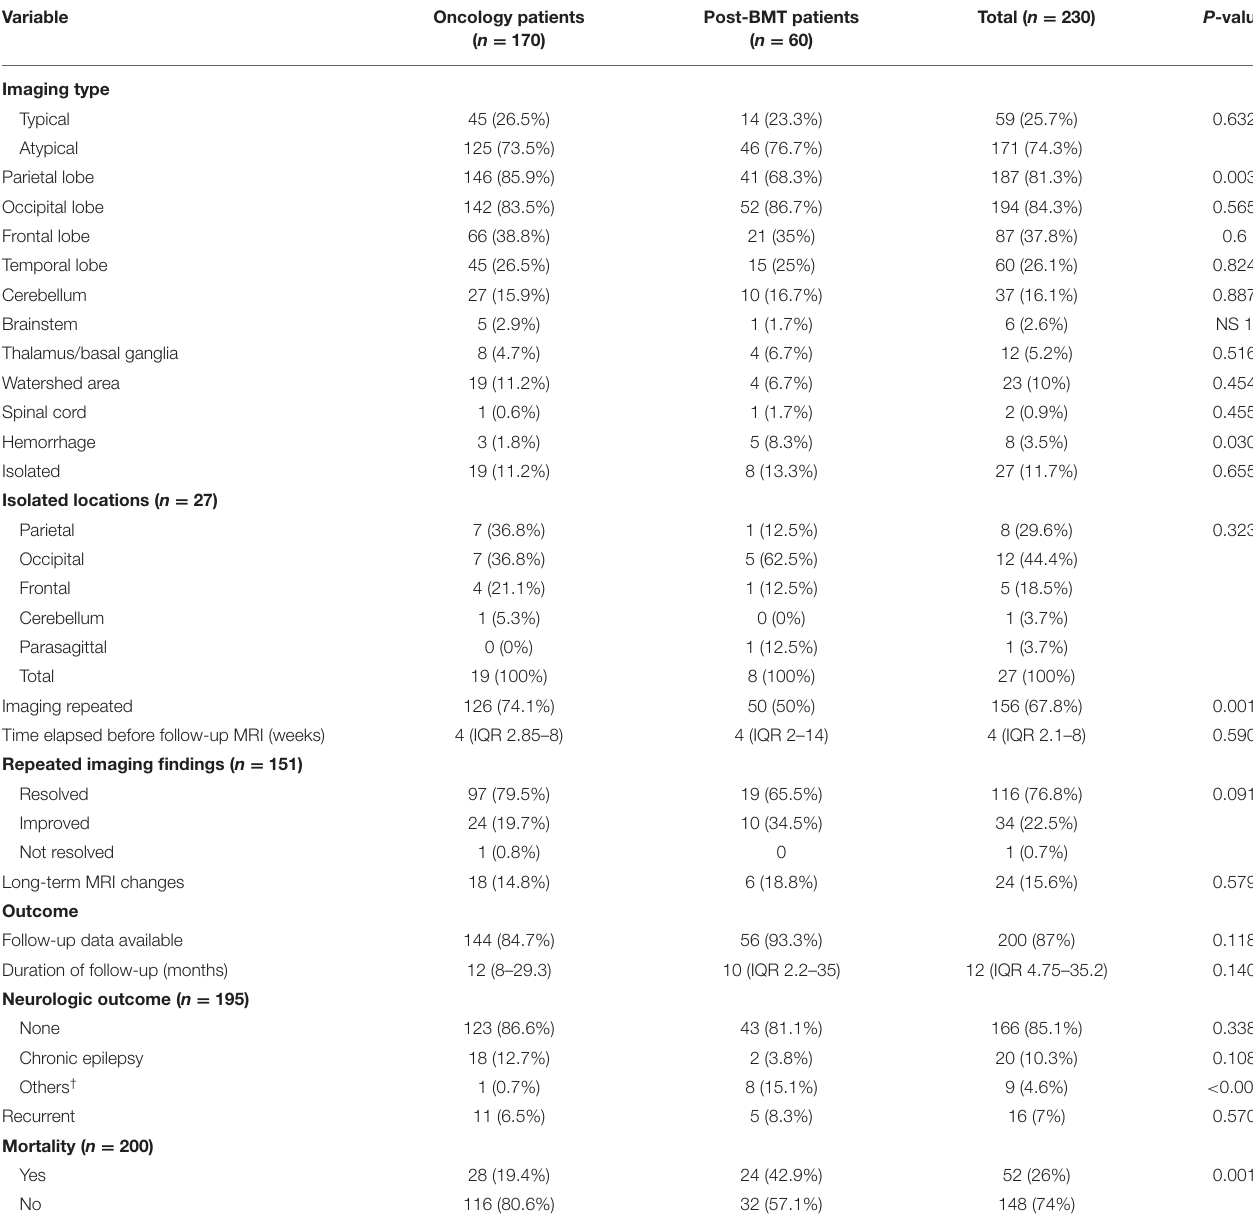
TABLE 3 | Comparison of imaging features and neurologic outcomes of PRES between oncology and post-BMT patients.